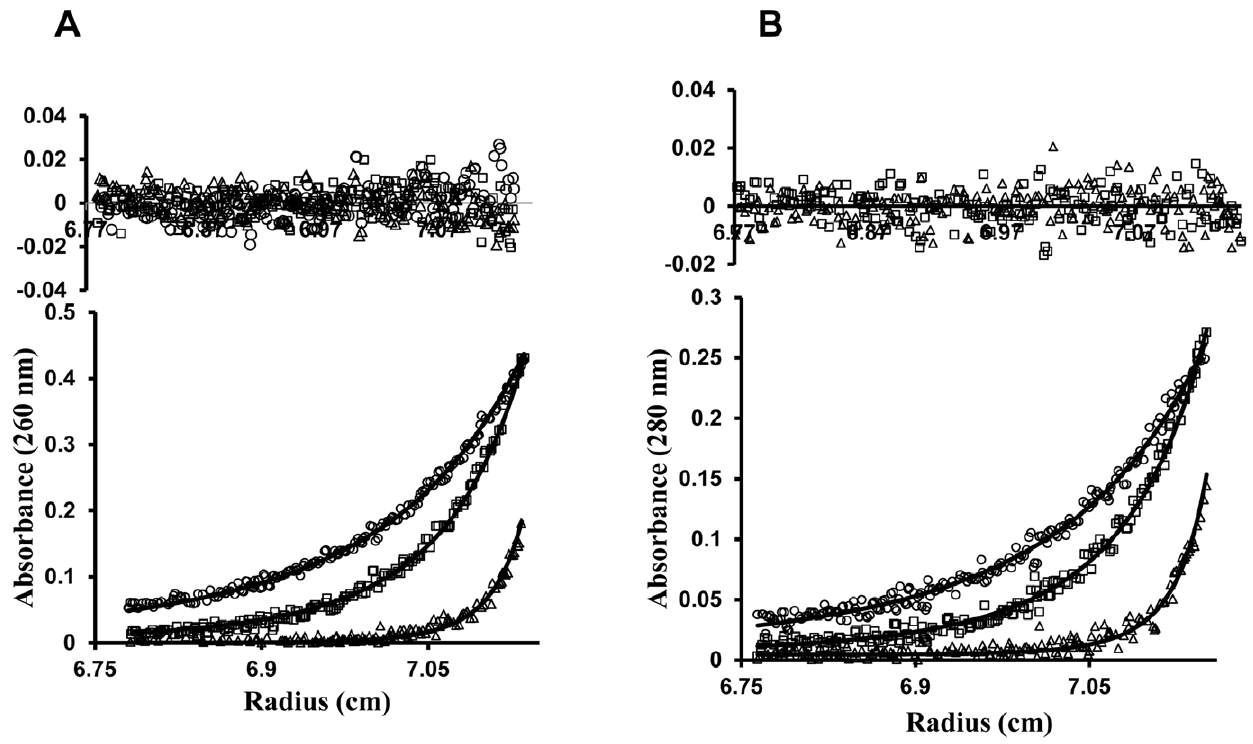
Figure 6. Sedimentation equilibrium analysis of the KdpE DBD — kdpFABC BS complex to determine the K d and stoichiometry. N Representative SE profiles of 0.63 m M kdpFABC BS and 2.5 m M KdpE DBD generated from data collected at 260 nm (A) and 280 nm (B) are shown. ), 19,800 ( % ) and 34,000 ( D ) rpm. The data were fit to a two site binding model with Mixtures of KdpE DBD and kdpFABCBS were spun at 9,000 ( symmetrical sites using SEDPHAT. The root mean square deviation values for the fits were 0.0039 and 0.0034 for samples at 260 and 280 nm, respectively. The residuals (inset) showed no systematic deviations. The fitted values are shown in Tables 2 and 3.